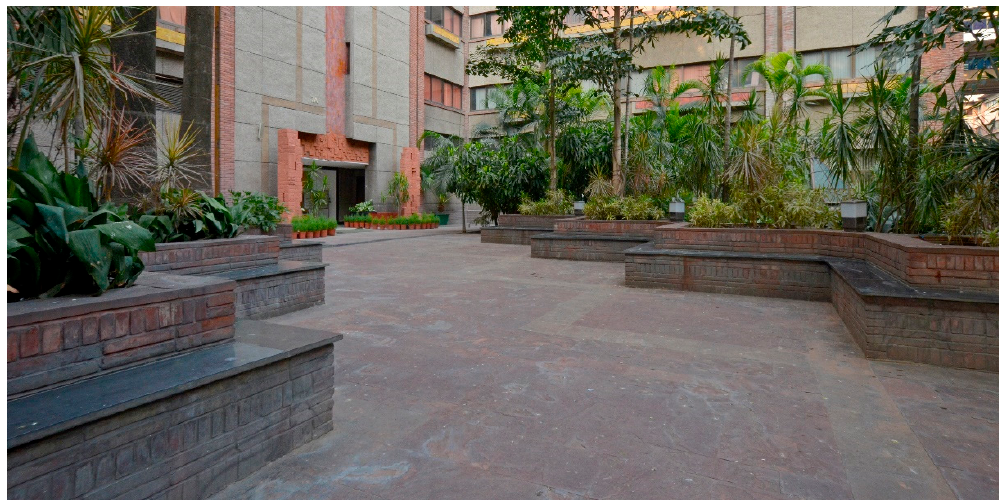
Figure 20. Seatwalls provided in the courtyards of India Habitat Centre (Photo: Author).